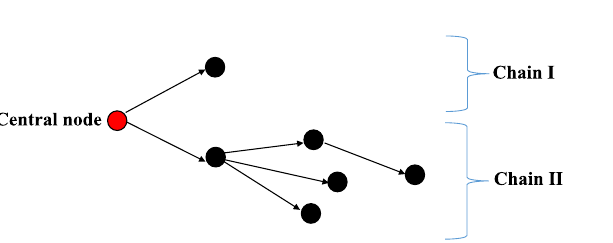
Figure 4. Example of a simplified transmission network with a group of 2 cases as the central node and a total of 2 chains in the